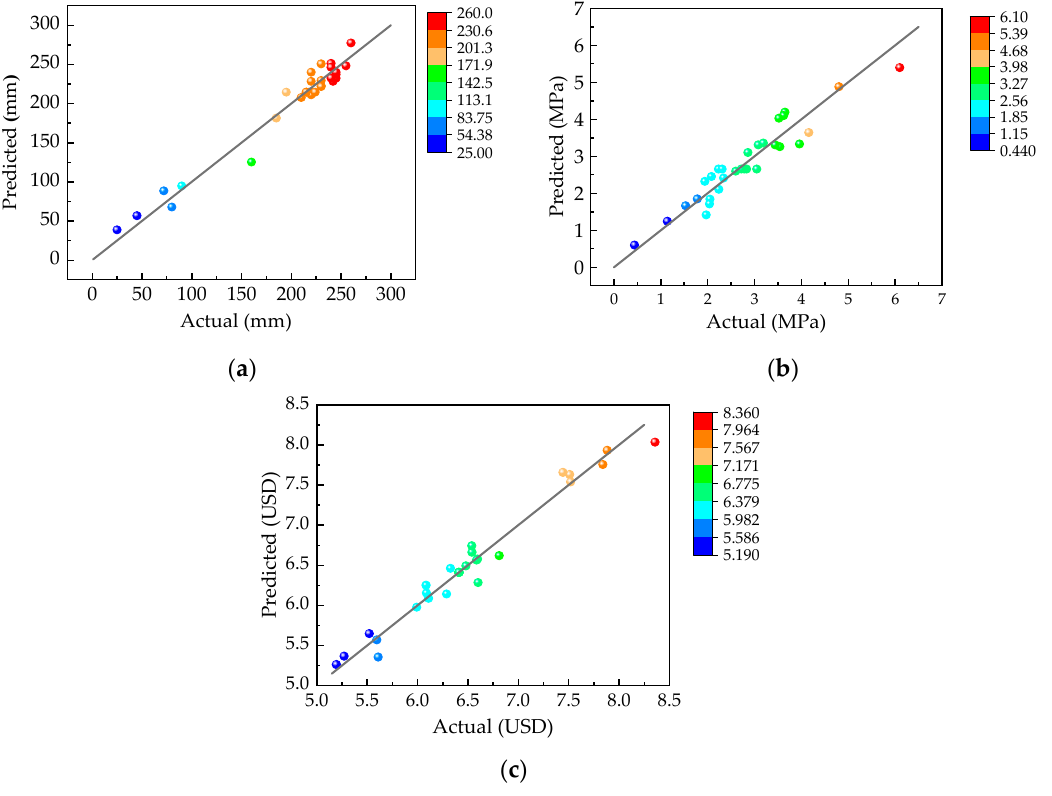
Figure 3. Comparison of predicted and true values: ( a ) Comparison of predicted and true values for slump; ( b ) comparison of predicted and true values for 28-d unconfined compressive strength (UCS); and ( c ) comparison of predicted and true values for cost. Table 5. Model validation for the response.